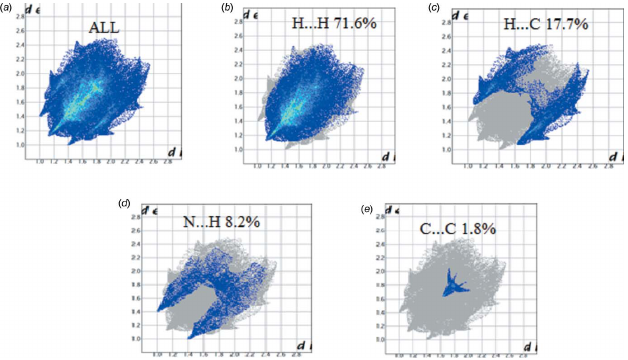
Figure 9 Two-dimensional fingerprint plots for compound (II): ( a ) all inter- molecular interactions; ( b ) H (cid:2)(cid:2)(cid:2) H contacts; ( c ) H (cid:2)(cid:2)(cid:2) C contacts; ( d ) N (cid:2)(cid:2)(cid:2) H contacts; ( e ) C (cid:2)(cid:2)(cid:2) C